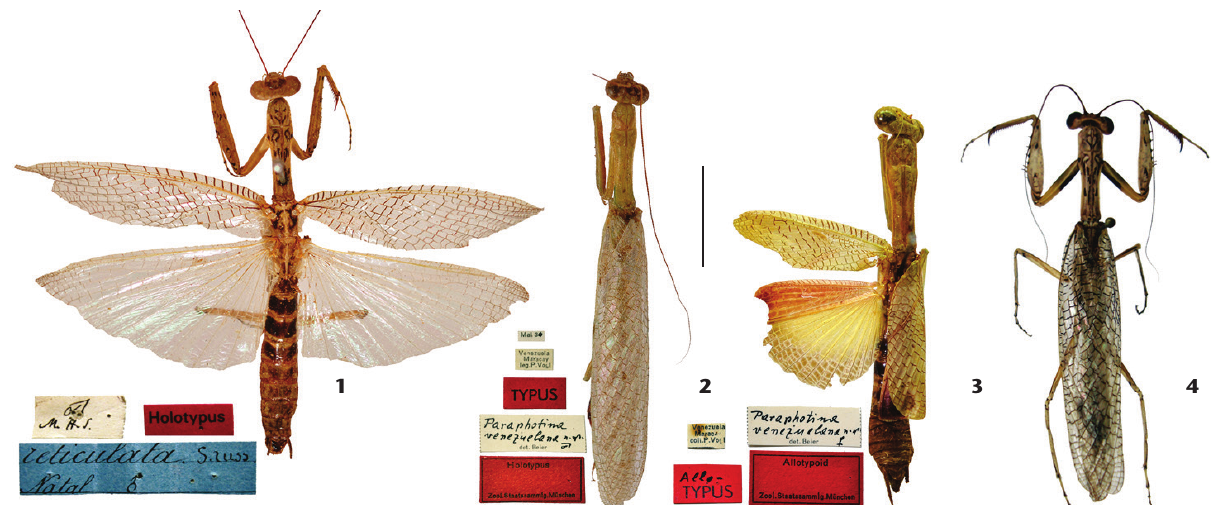
Figures 1-4. Types of Paraphotina (dorsal habitus): (1) Paraphotina reticulata (originally Cardioptera reticulata Saussure, 1871) holotype male deposited in MHNG; (2-3) Paraphotina venezuelana , (2) holotype male, (3) allotype deposited in ZSM; (4) Paraphotina caatingaensis comb. nov. (originally Orthoderella caatingaensis Menezes & Bravo, 2013) holotype male deposited in MZFS. Arrow highlights the basal spot on fore coxa. Scale bar: 10 mm. Photo of P. caatingaensis courtesy of E. Menezes